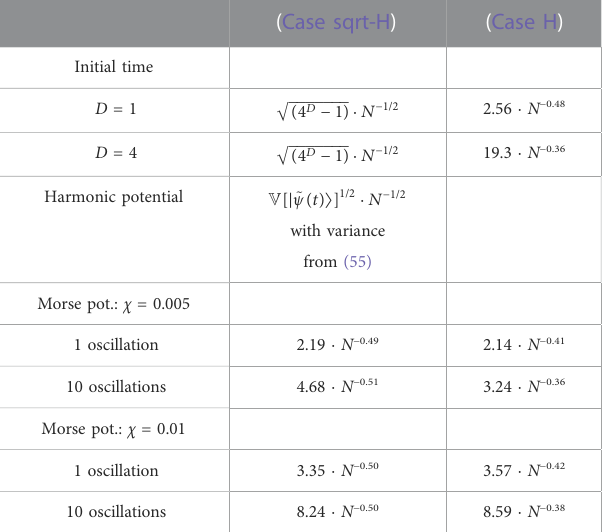
that results are numerically converged is con fi rmed in the lower panel of Figure 8, where the errors of (Case H) and (Case sqrt-H) are approximately the same, which implies that the common remaining error is the error of the Herman – Kluk approximation and not the phase- space discretization error.